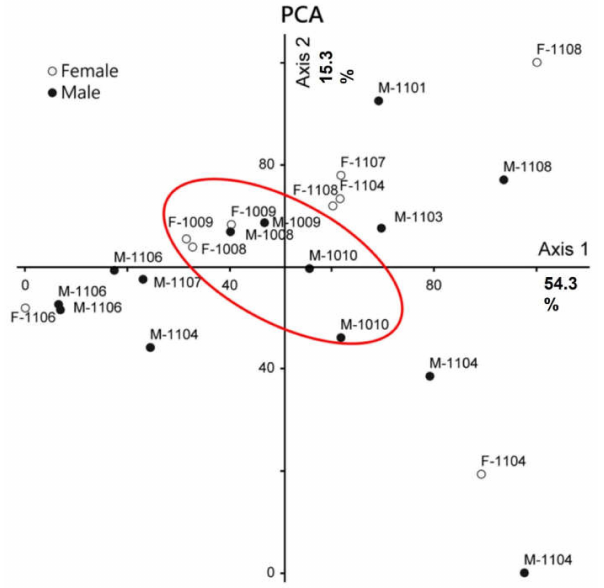
Figure 2. Principal component analysis (PCA) of volatile bouquets between receptive female (hollowed circle) and male (filled circle) figs; The fourth first digits of each triangle represent the date